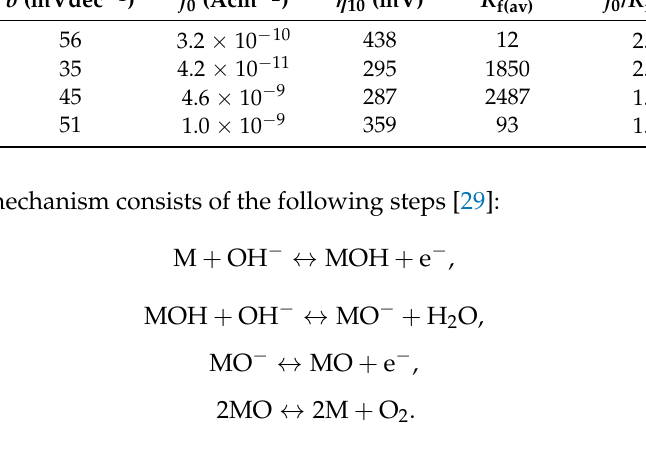
Table 1. The Tafel slope b , the apparent exchange current density j 0 , the overpotential at a current density of 10 mAcm − 2 η 10 and the average roughness factor R f(av) obtained for CoFe 2 O 4 electrodes in 1 M KOH solution during OER.